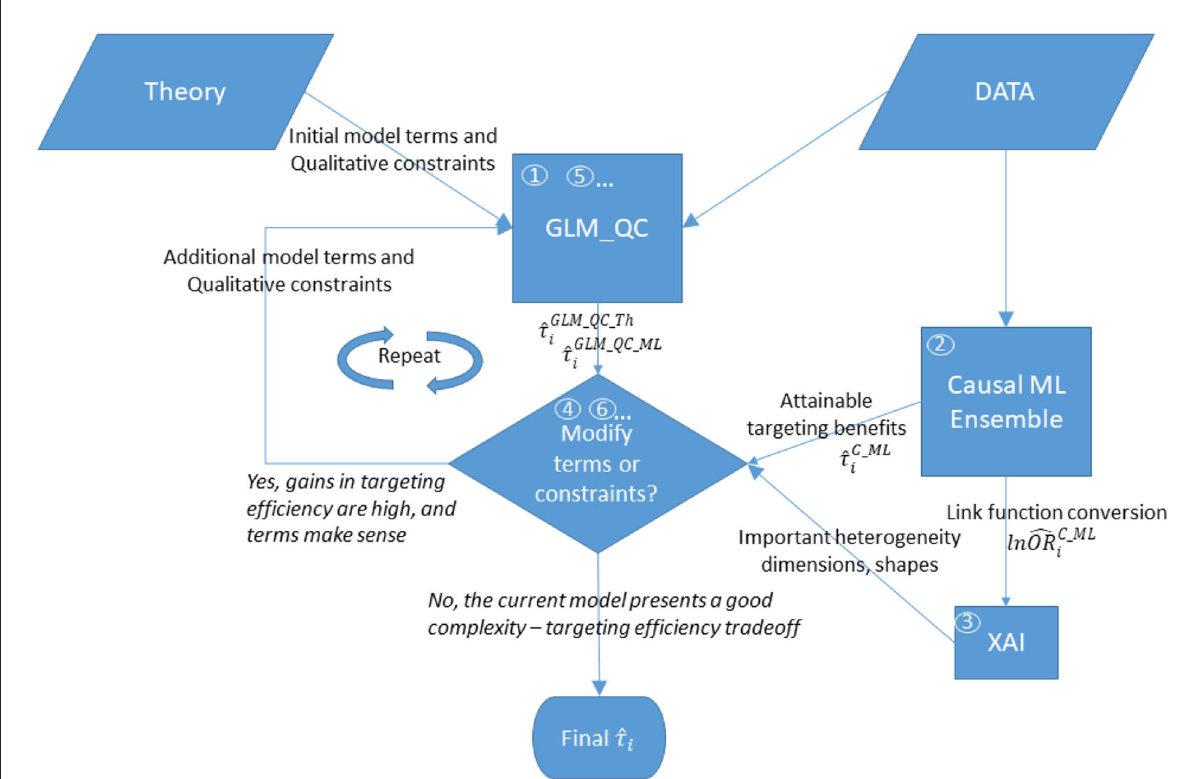
FIGURE1 Overview of the proposed methodology. The numbers in circles represent the order of the steps, where boxes “GLM_QC” and “Modify terms or constraints?” are repeated until the modeler decides not to modify the model.